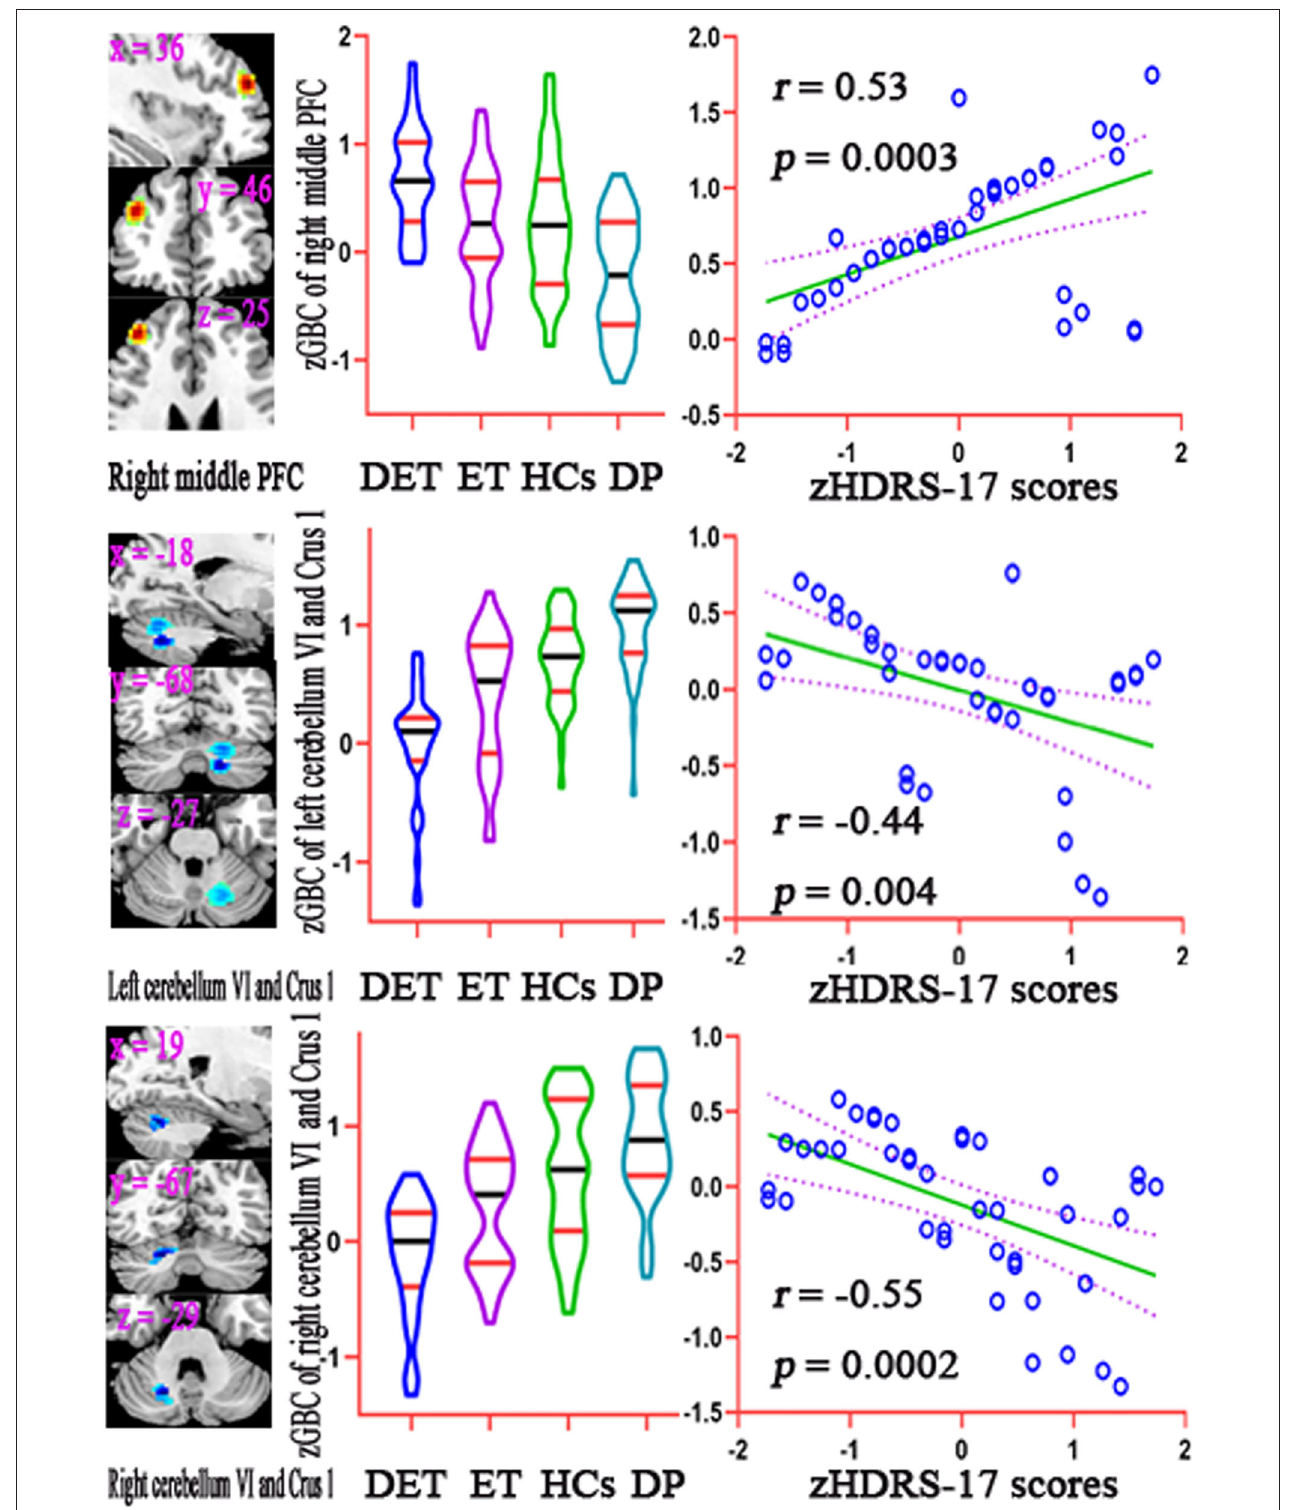
FIGURE 4 | Results of correlation analysis between the GBC values of significant discriminative features and the HDRS-17 scores in patients with depressed ET. Bonferroni multiple comparison corrections, corrected P < 0.05/12 × (12–1)/2. Left: the cluster of the significant discriminative features. Middle: mean GBC values in the significant discriminative regions among DET, ET, HC, and DP groups. Right: the scatter plots for the correlation analysis in patients with depressed ET. GBC, global brain connectivity; PFC, prefrontal cortex; zGBC, z-transformed global brain connectivity; zHDRS-17 scores, z-transformed Hamilton Depression Rating Scale 17-item scores; DET, depressed essential tremor; ET, essential tremor; HCs, healthy controls; DP, primary depression; HDRS-17, 17-item Hamilton Depression Rating Scale.